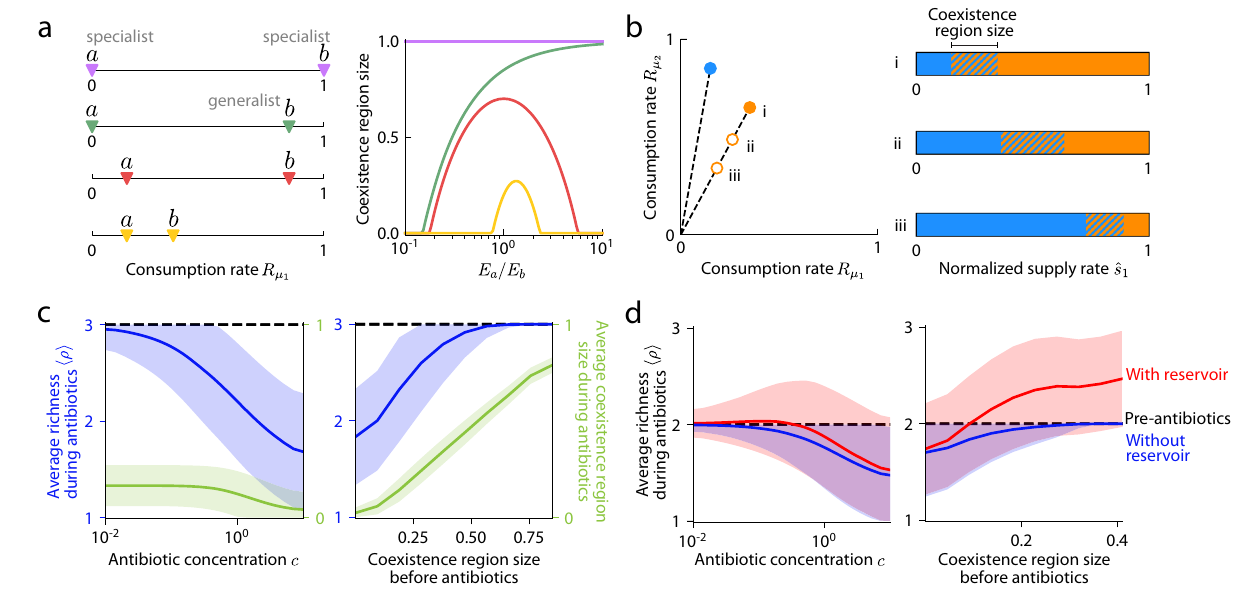
Fig. 2 | Resource competition results in complex dependence of species coex- istence on antibiotic activity. a Effect of antibiotic activity on two species ( a and b )competingfortworesources.(Left)Fourtypesofcommunitieswithqualitatively distinct consumption niches were considered, including a specialist and a gen- eralist (green), two specialists (purple), two symmetrically distributed generalists (red), and two asymmetrically distributedgeneralists (yellow).(Right) The fraction of supply rates that lead to coexistence (coexistence region size) can depend non- monotonically on the relative enzyme budget ( E a = E b for species a and b on the left). b Example community consisting of a non-targeted species (blue) and a tar- geted species (orange) that was initially more of a generalist (more equal con- sumption of both resources). (Left) Antibiotic activity resulted in decreased enzyme budget (empty circles).(Right) Mapof coexistenceregions asinFig. 1e for the scenarios on the left. c Average richness during antibiotic perturbation (blue) and average coexistence region size during antibiotic perturbation (green)